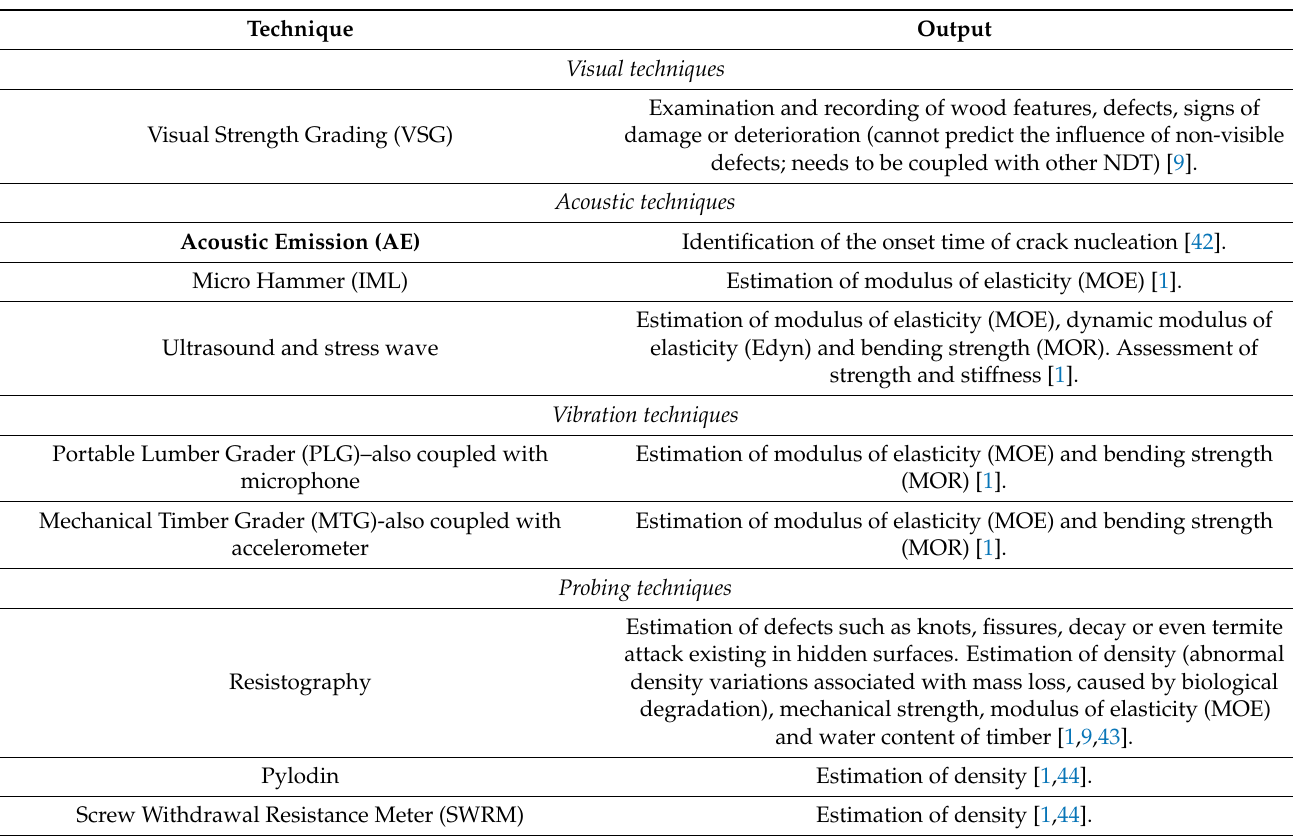
Table A1. Non-destructive techniques mainly used for timber grading and assessment of existing timber structures and their corresponding